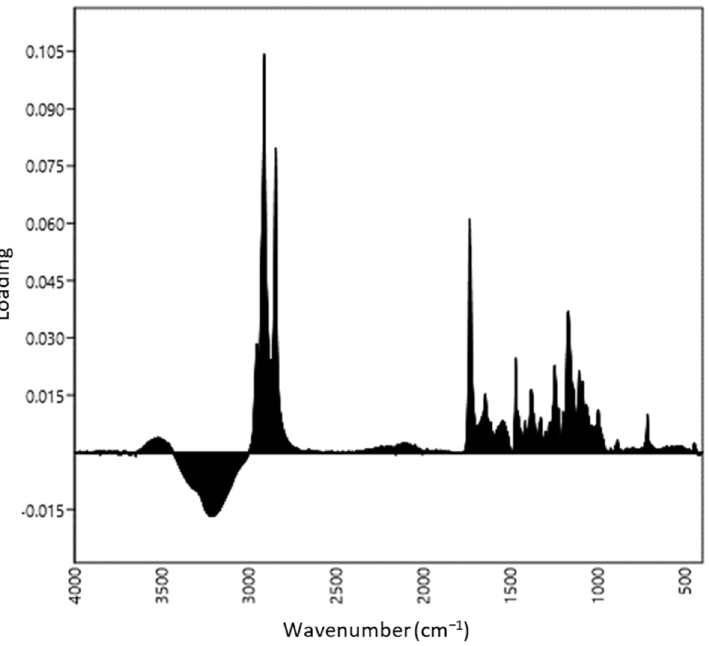
Figure 2. Loadings plots produced by PC 1 with peaks at 1173, 1248, 1471, 1737, 2849, 2913 and 2958 cm − 1 .